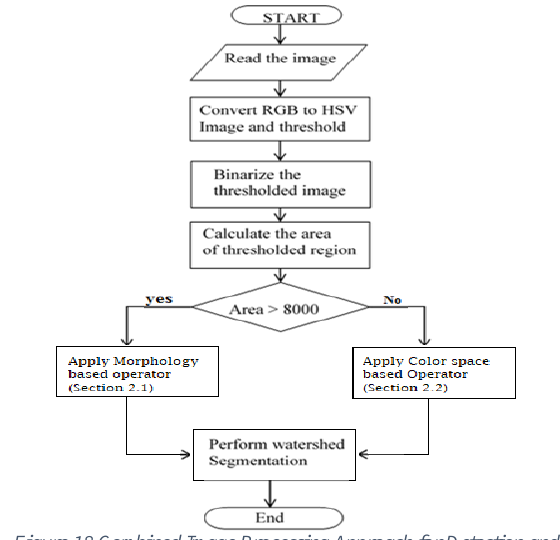
Figure 18 Combined Image Processing Approach for Detection and Counting Trees